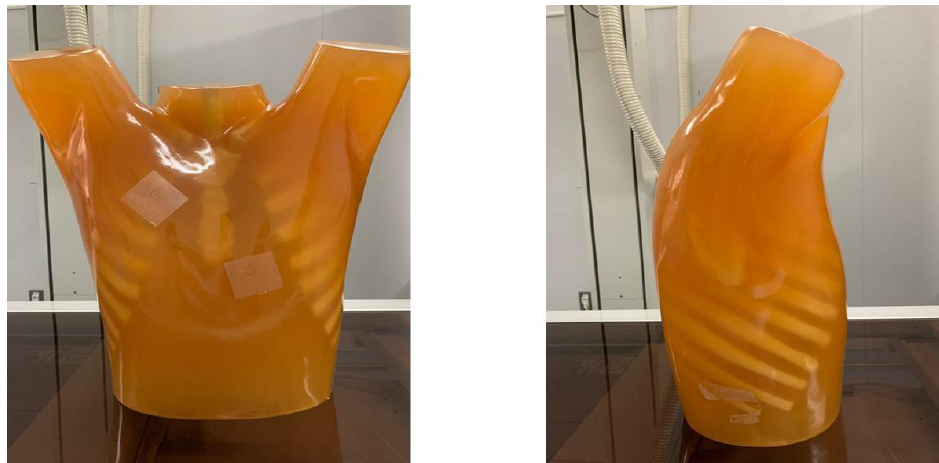
Figure 2. An anthropomorphic chest phantom used in this study.